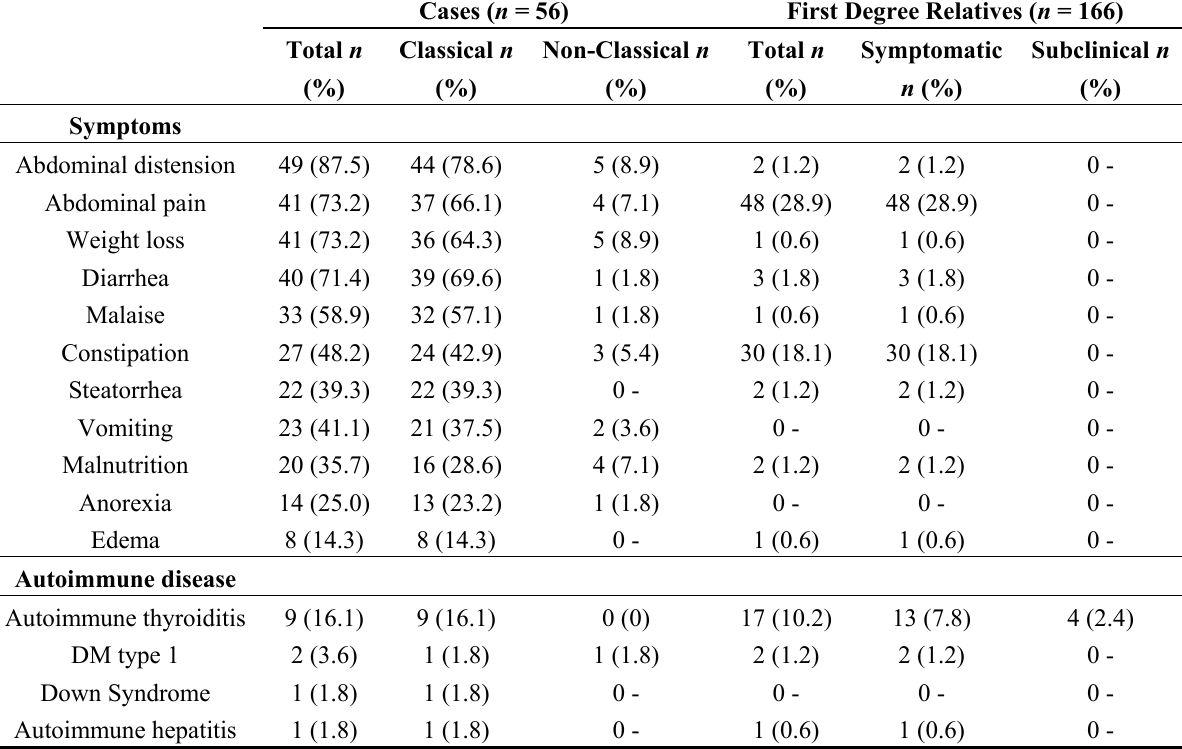
Table 2. Symptoms, autoimmune diseases and other diagnoses detected in celiac cases and their first-degree